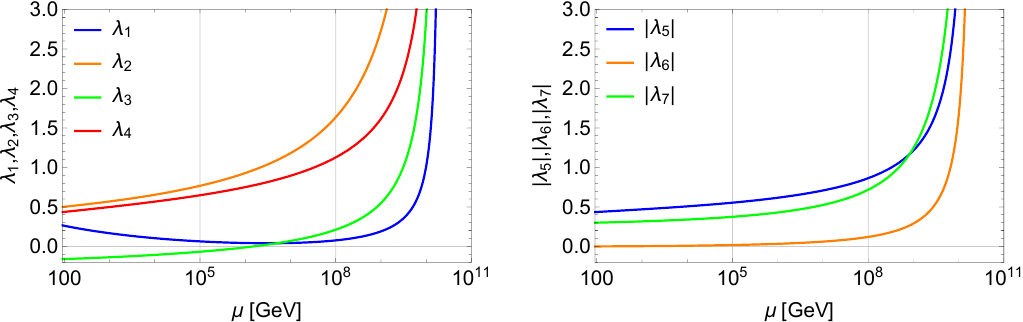
Figure 11 . RGE-running behavior of the Higgs self couplings from m Z with the benchmark parameters given in table 3. The left (right) panel corresponds to (cid:21) 1-4 ( j (cid:21) 5-7 j